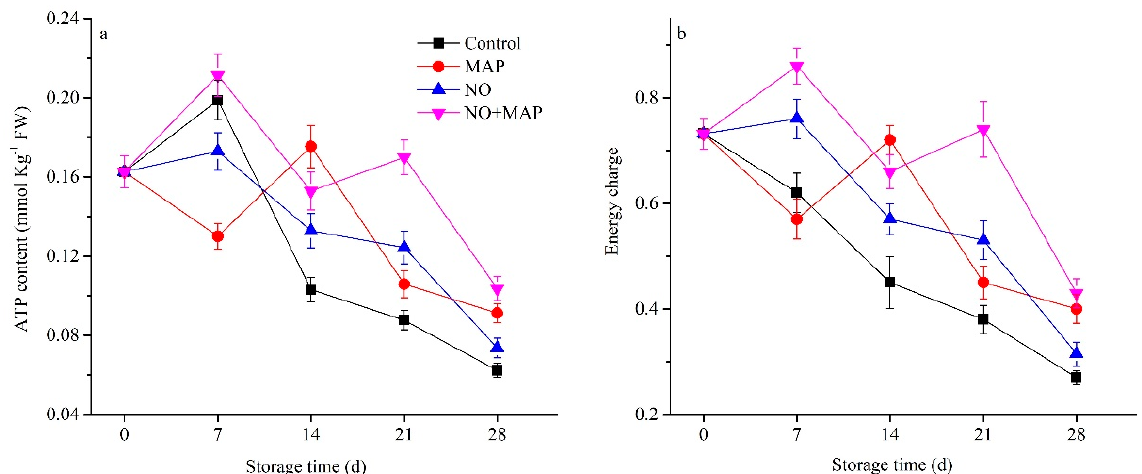
Figure 3. Effects of NO and MAP treatment on ATP ( a ) and energy charge ( b ) in water bamboo shoots stored at 4 °C for 0, 7, 14, 21, and 28 d. Values are presented as mean ± SD.